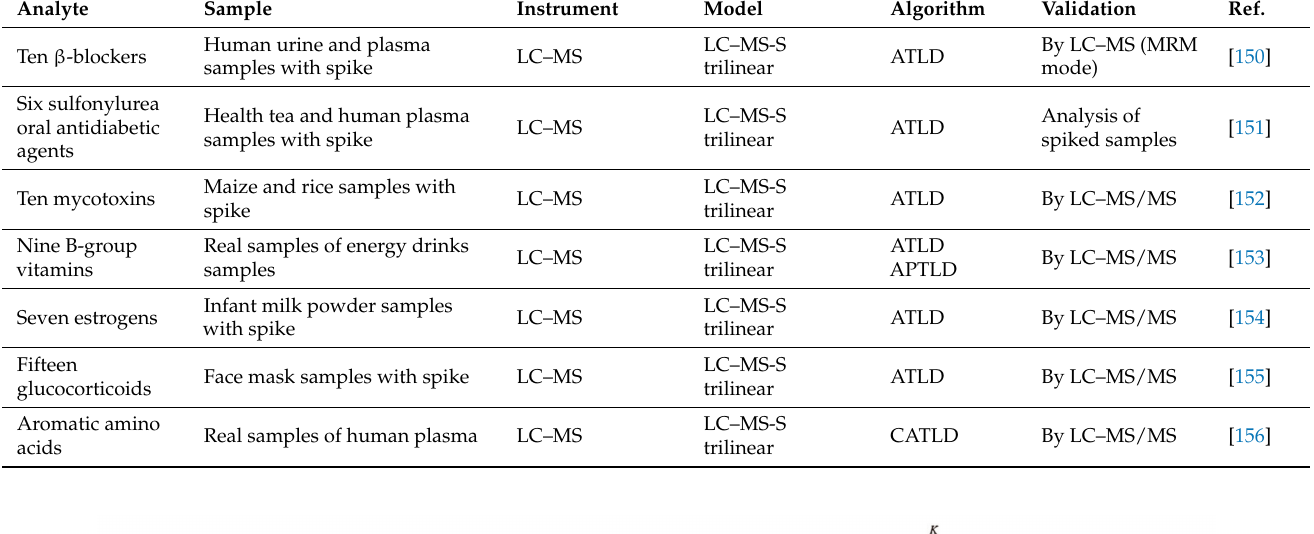
Table 4. Analytical applications of liquid chromatography–mass spectrometry (LC–MS) assisted by three-way analysis based on the trilinear model.